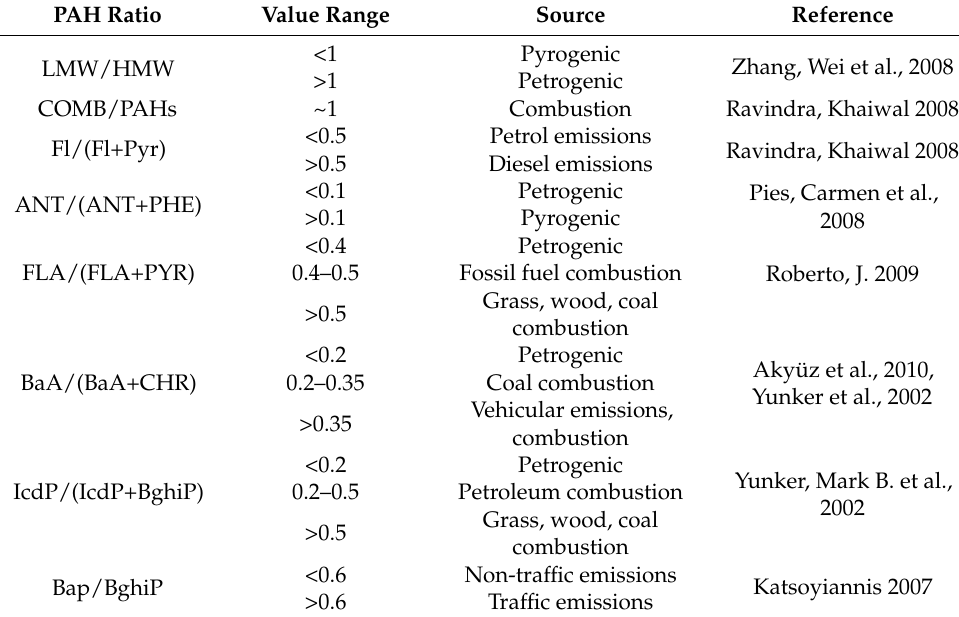
Table 1. Diagnostic ratios used with their typically reported values for particle processes. PAH Ratio Value Range